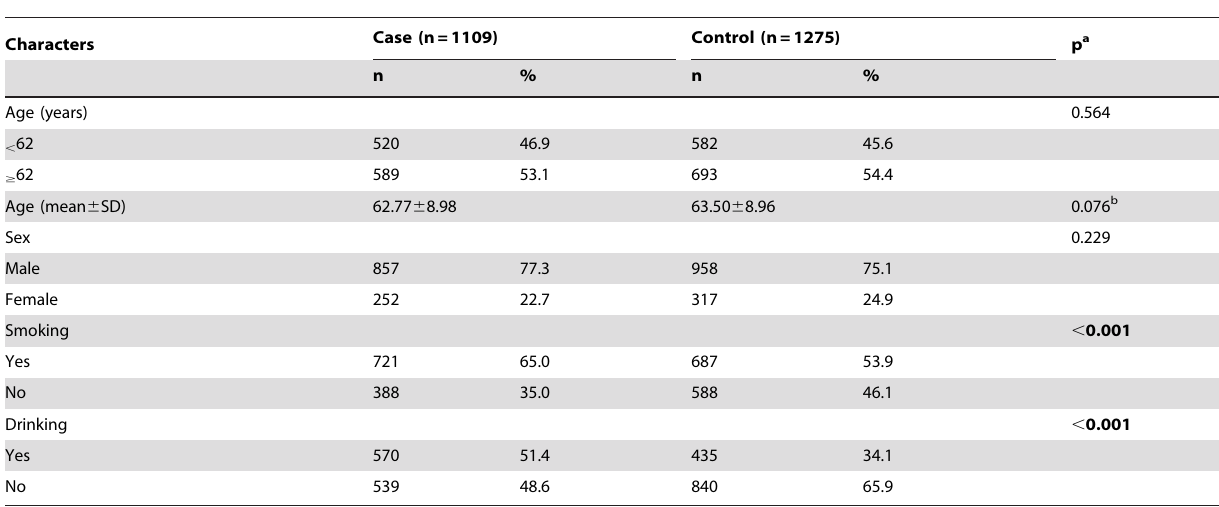
Table 1. Characteristics of case and control